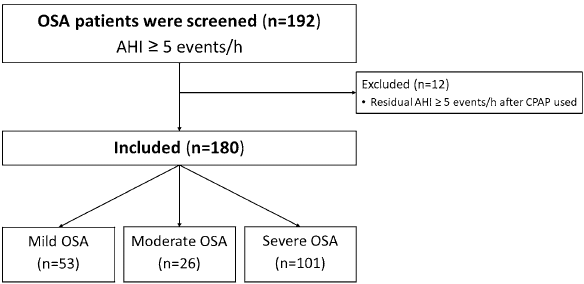
Figure 1. Flowchart of the study in OSA patients. AHI Apnea–hypopnea index, CPAP Continuous positive airway pressure, OSA Obstructive sleep